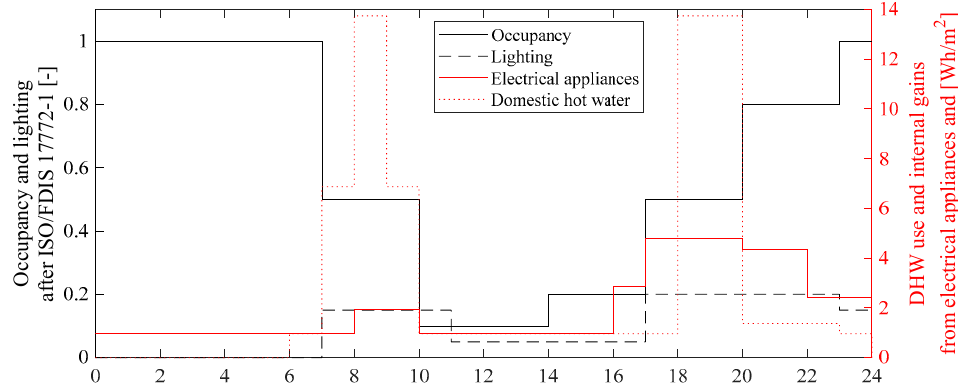
Figure A1. Daily profiles for DHW use and internal heat gains from electrical appliances, occupancy and lighting [15]. Table A1. Comparison of CO 2 factors per electricity generation technology (EGT) from different references [39].